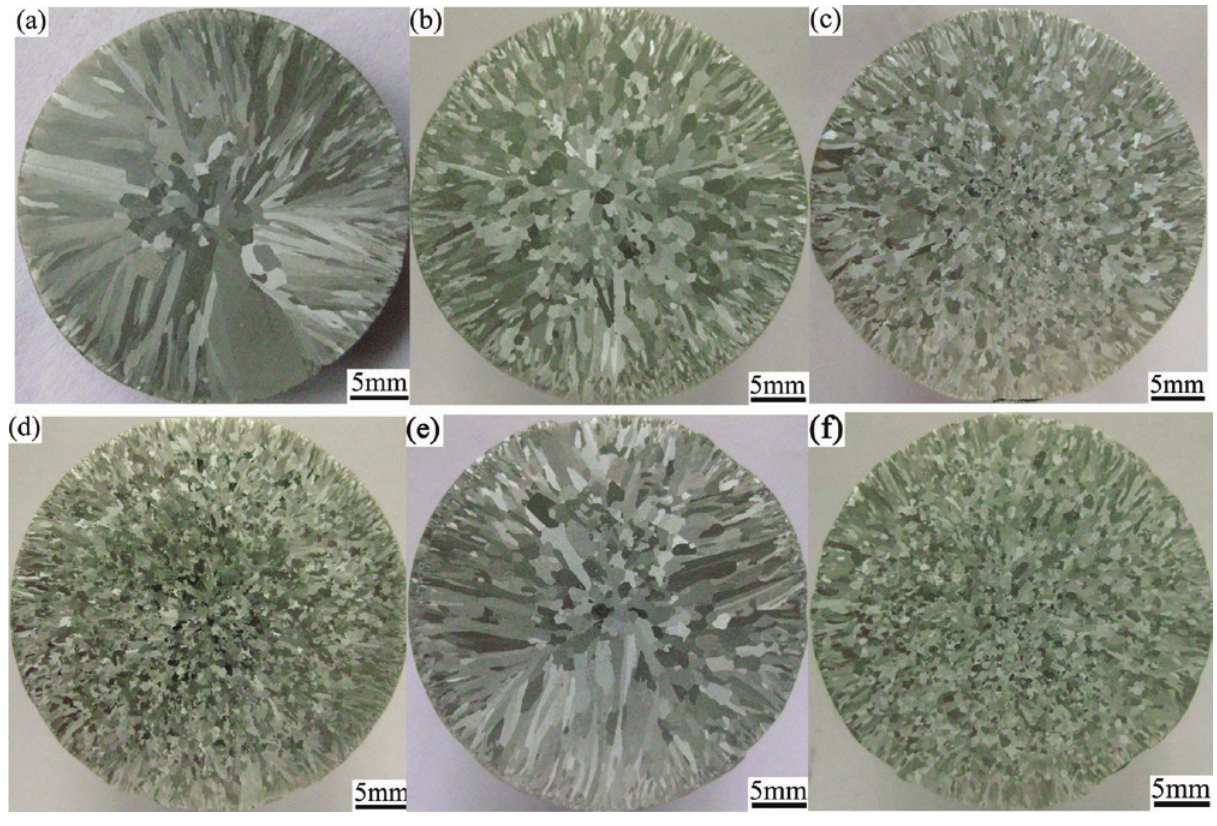
Fig. 2: Macrostructures of the tested cylindrical ingots